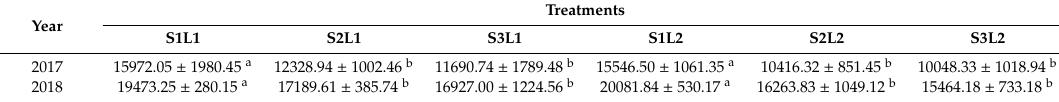
Table 3. Comprehensive global warming potential under di ff erent treatments [kg (CO 2 -C) · hm − 2 ] *.